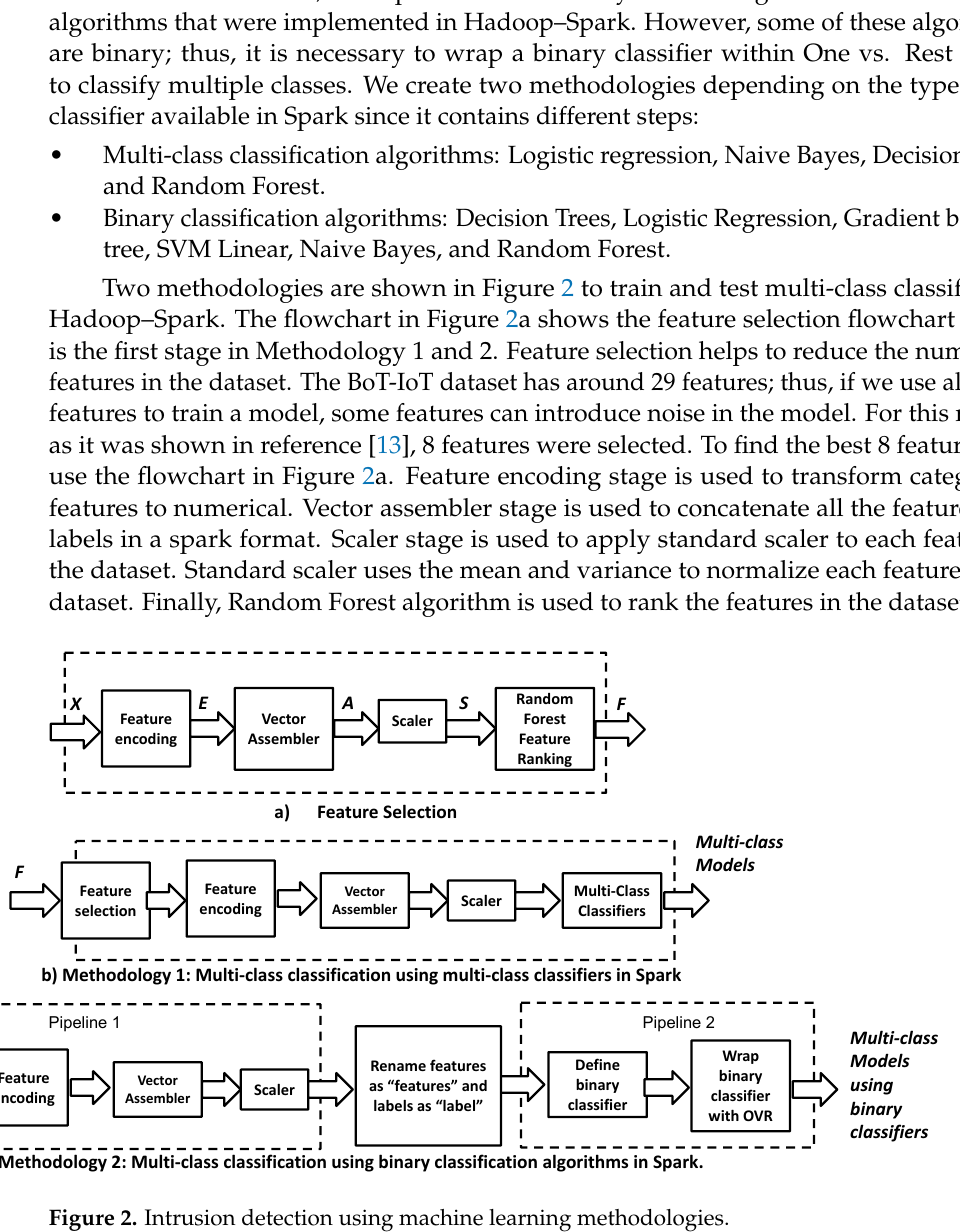
Figure 2. Intrusion detection using machine learning